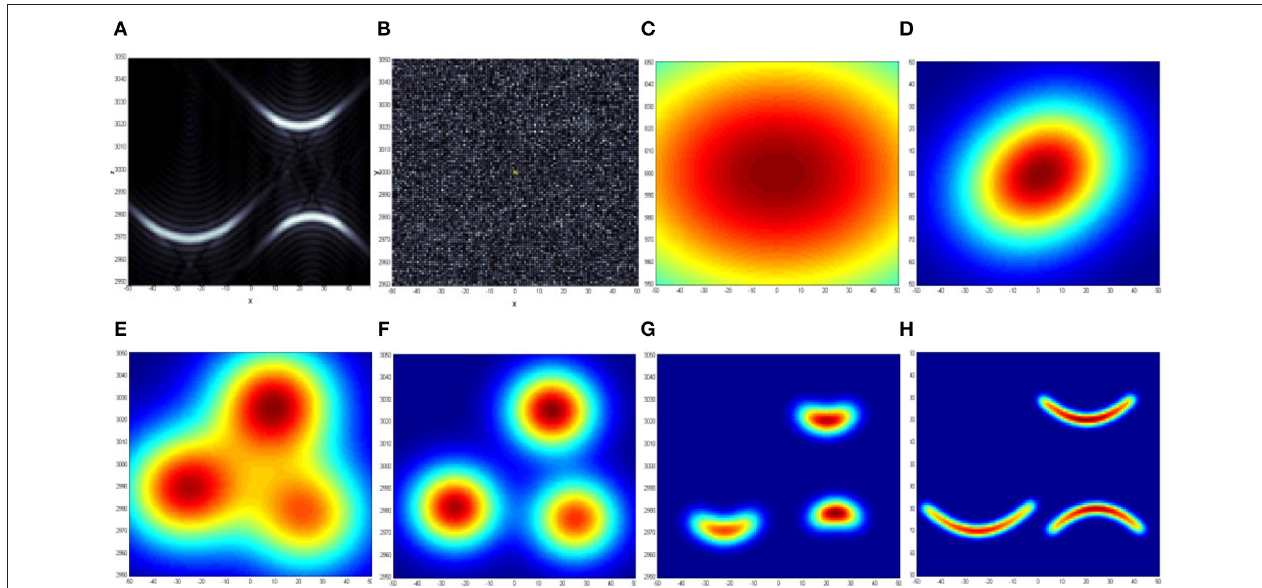
FIGURE 3 | Perception of “smile” and “frown” patterns in noise, an example of dynamic logic “from vague-to-crisp” process: (A) true “smile” and “frown” patterns are shown without noise; (B) actual image available for recognition (signals are below noise, signal-to-noise ratio is about 1/3); (C) an initial vague concept-model; (D) through (H) show improved concept-models at various iteration stages (total of 21 iterations). Between stages (D) and (E) DL tries to fit the data with more than one model and decided, that it needs three models to “understand” the content of the data. Until stage (G) the DL “thought” in terms of simple blob models, at (G) and beyond, the algorithm decided that it needs more complex parabolic models to describe the data. Iterations stopped at (H) , when similarity (3) stopped increasing.